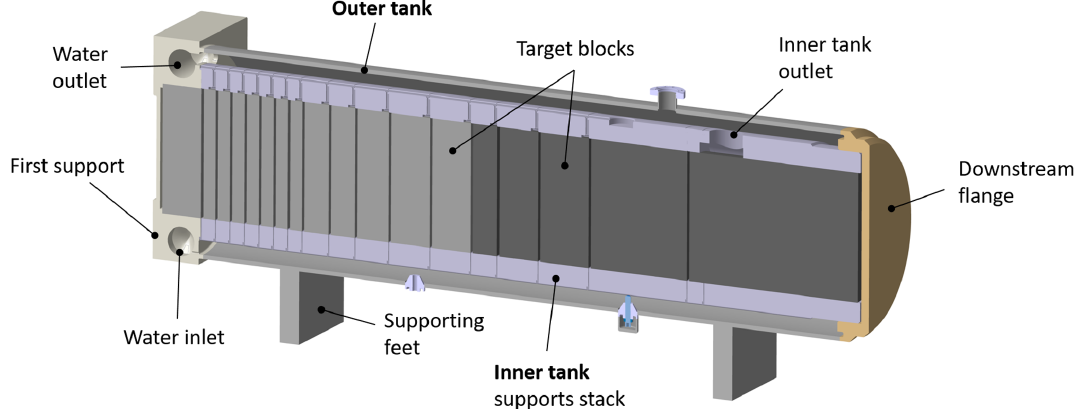
FIG. 14. Longitudinal section of the BDF target inner and outer tank structure. The target blocks supported by the inner tank can be seen, as well as many functional elements of the cooling circuit and the supporting structure of the target itself.